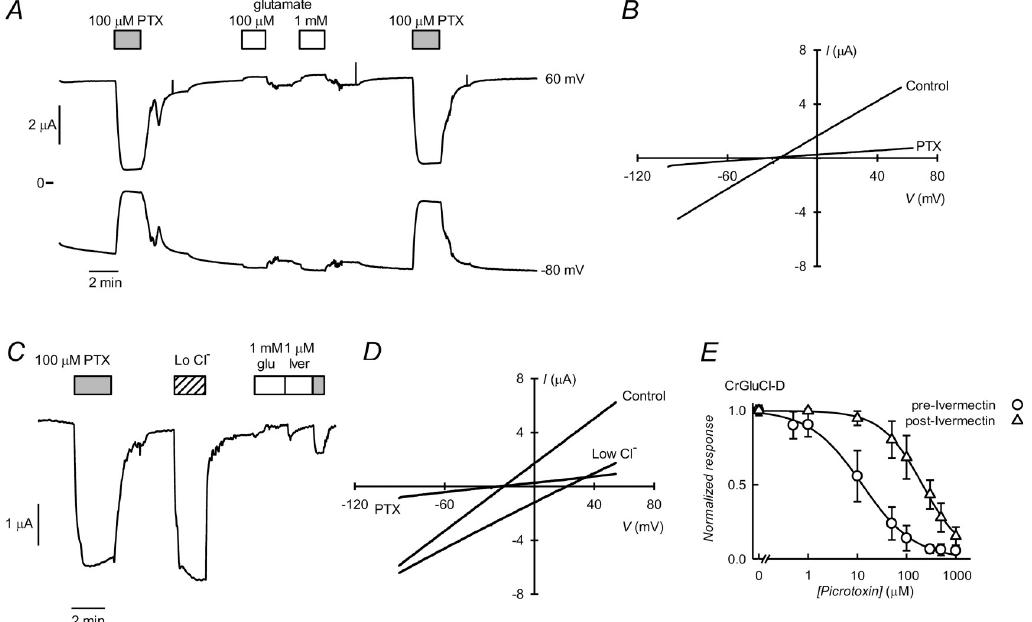
Fig 7. Spontaneously active currents are present in oocytes injected with CrGluCl-D cRNA. A. Currents are measured at the indicated voltages and PTX or glutamate additions are as indicated. Large inward and outward currents were markedly inhibited in a reversible way by PTX. Addition of 100 μ M and then 1 mM glutamate produced only a very slight effect B. IV currents taken from A before or after inhibition with 100 μ M PTX. C. Traces taken at 60 mV show current chloride dependence and the lack of effect of ivermectin. PTX effect is decreased by previous ivermectin treatment. D. IV curves correspond to trace in C and represent initial control spontaneous current with no addition and in the presence of PTX or low extracellular chloride. E. Effect of increasing concentrations of PTX on currents taken from oocytes expressing CrGluCl-D either without any pre-treatment (pre-ivermectin) or after a ~2 min exposure to 1 μ M ivermectin (post-ivermectin). Results are means ± SD, n = 11 and 12